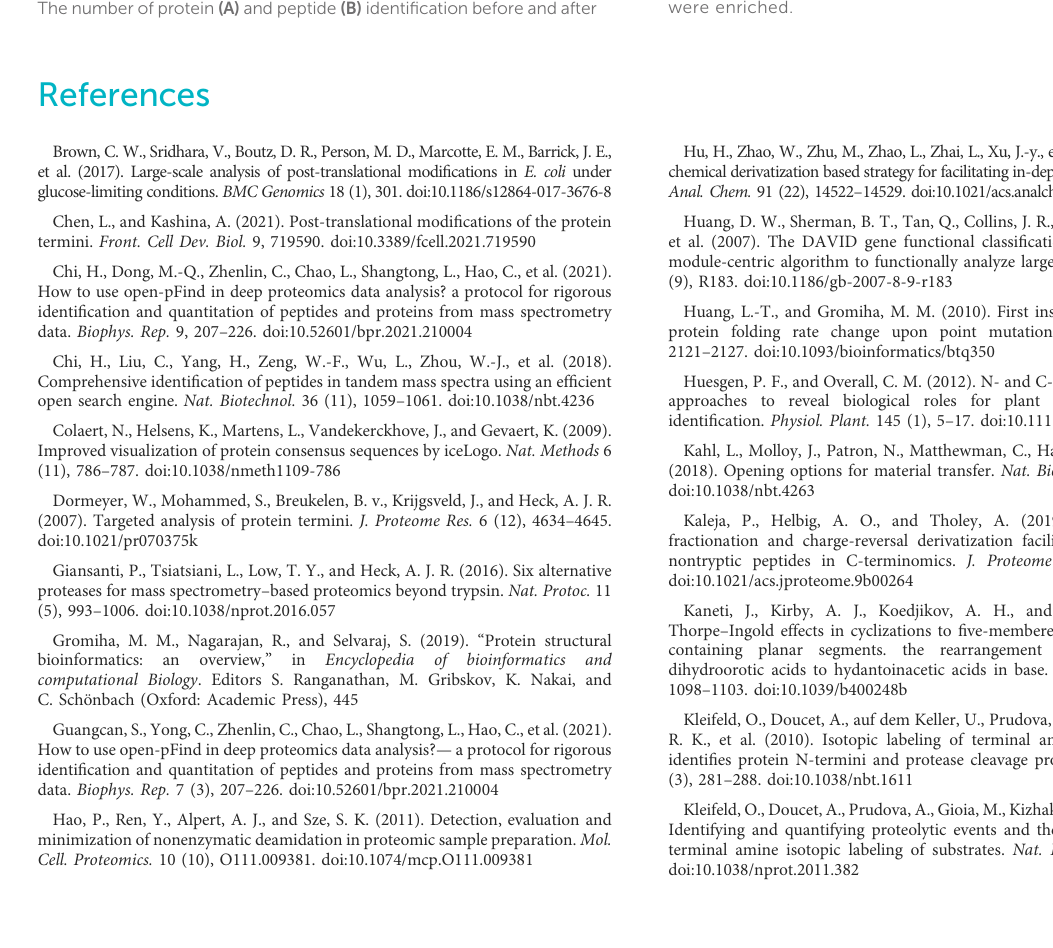
identi fi ed number distribution of full labeling (D) and un-labeling (E) peptide on different fi rst three amino acids. (F) The histogram distribution of peptide retention time before and after labeling with 2-PCA. SUPPLEMENTARY FIGURE S2 The in fl uences of 2-PCA labeling ef fi ciency analysis of C-terminal peptides. The hydrophilic/hydrophobic value (A) and peptide length (B) comparison of 2-PCA fully-labeled, partially labeled, and unlabeled C-terminal peptides.Thep-valuewascalculatedbypairedStudent t -test. SUPPLEMENTARY FIGURE S3 The analysis of C-terminome data by using the PBC method. (A) Overlap analysis ofourC-terminomedata withotherpublisheddata. (B,C,D) The distribution comparison of the fi rst amino acid (B) , second amino acid (C), and third amino acid (D) between enriched C-terminal peptide and theoretical C-terminal peptide. The theoretical C-terminal peptide was generated from in silico digestion of whole human proteome by using LysC. (E) The MS/MS spectrum for truncated C-terminal peptides from HSP90AB1. SUPPLEMENTARY FIGURE S4 The analysis of truncations and PTMs on histone. SUPPLEMENTARY FIGURE S5 The further optimized PBC method. The PBC method could be simpli fi ed and optimized into one-step chemical derivatization for C-terminal peptide enrichment. After PCA labeling, the protein N-terminal peptides and internal LysC peptides could be depleted through commercially available hyperbranched polyaldehyde polymers (HPG-ALD polymers) directly and the C-terminal peptides were